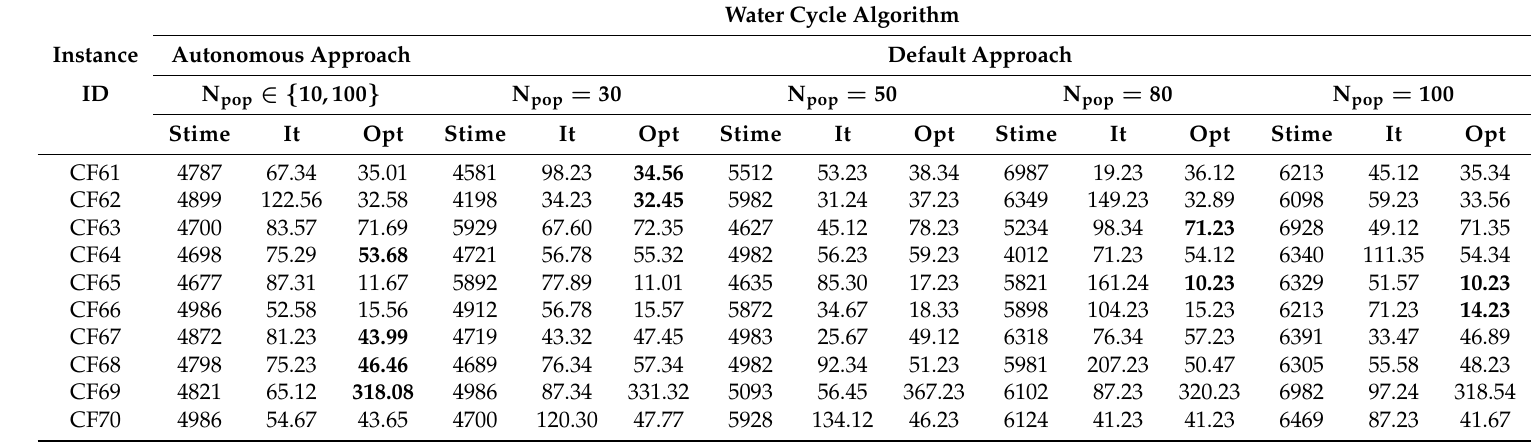
Table 11. Results solving complex instances (3/3). Water Cycle